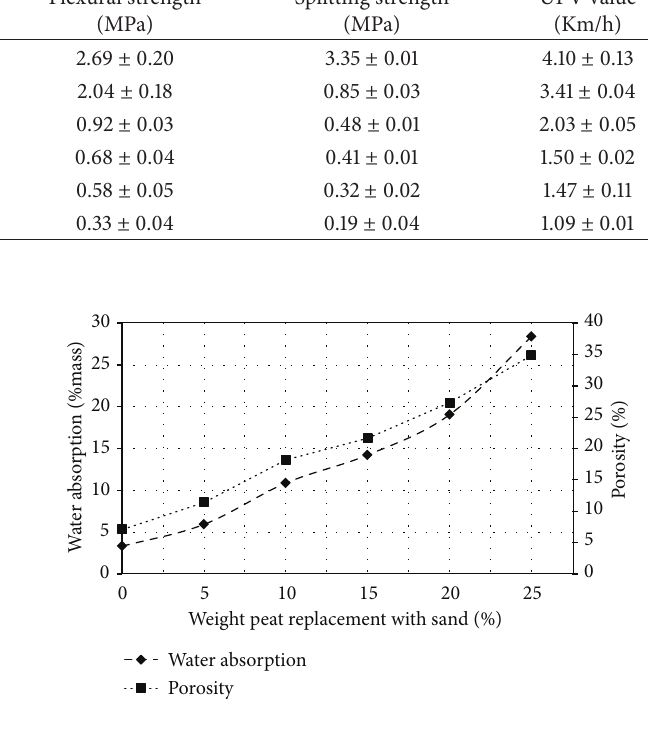
Figure 4: Water absorption and porosity with percentage of peat replacement with sand.